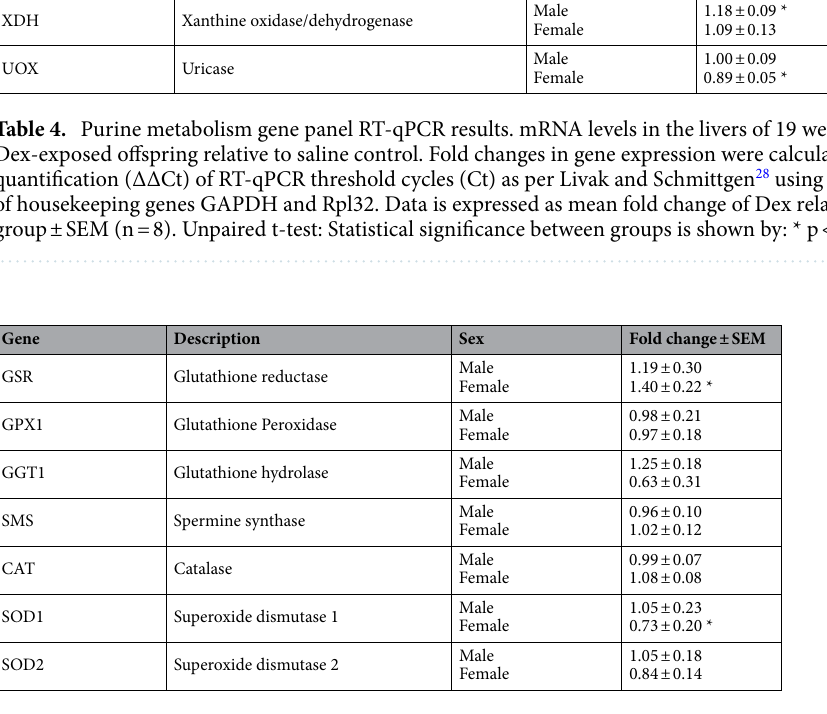
Table 5. Glutathione metabolism gene panel RT-qPCR results. mRNA levels in the livers of 19 week old prenatally Dex-exposed offspring relative to saline control. Fold changes in gene expression were calculated by relative quantification (ΔΔCt) of RT-qPCR threshold cycles (Ct) as per Livak and Schmittgen 28 using mean Ct values of housekeeping genes GAPDH and Rpl32. Data is expressed as mean fold change of Dex relative to the saline group ± SEM (n = 8). Unpaired t-test: Statistical significance between groups is shown by: * p < 0.05.